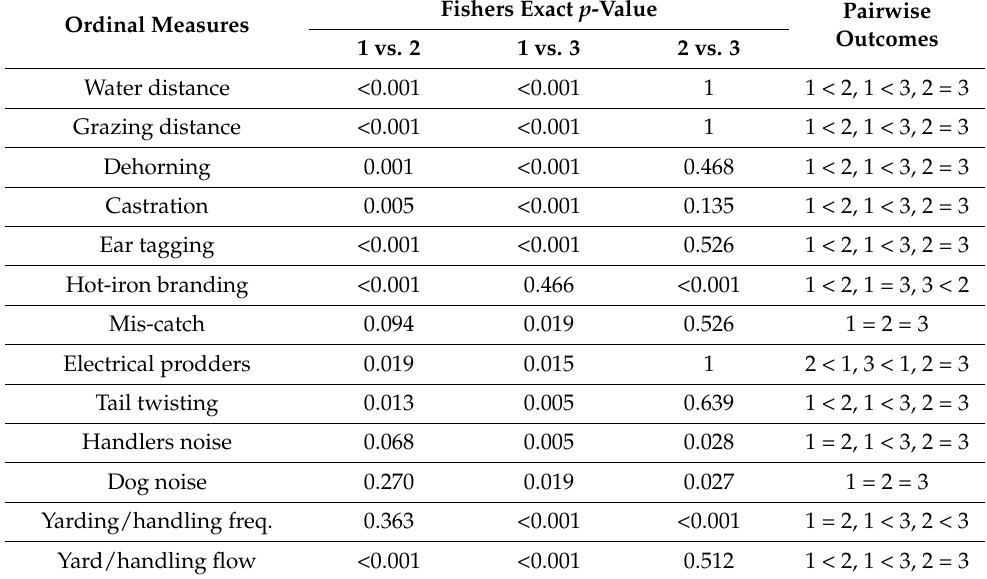
Table 4. Pairwise comparisons for the Fishers exact test for the frequency of categorical measures at the cow–calf production systems herds in Namibia (1—Commercial ( n = 17), 2—Semi-commercial ( n = 20), 3—Communal ( n =